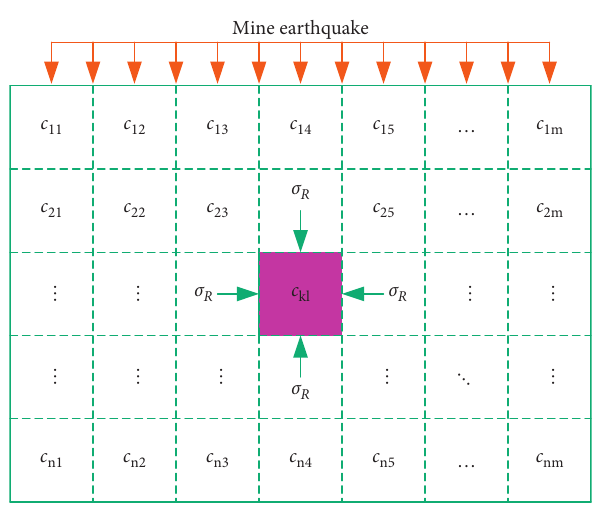
Figure 5: Rock block action